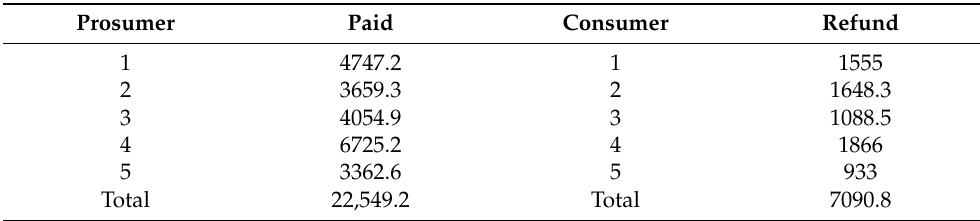
Table 7. The number of tokens paid to prosumers and the refund to consumers.